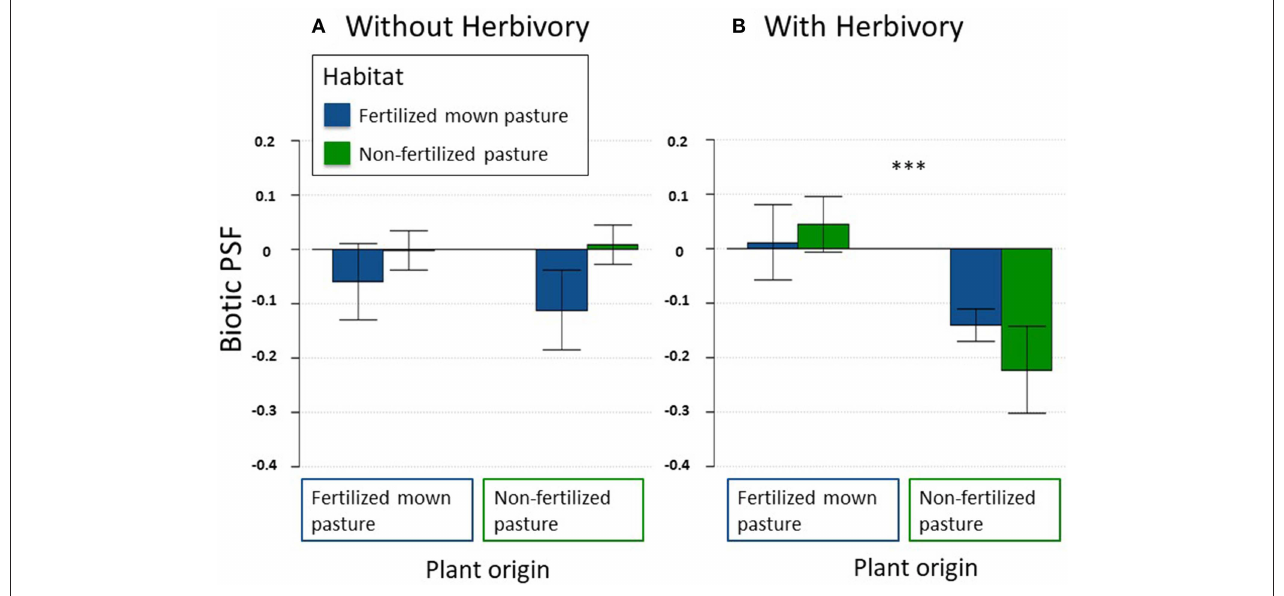
FIGURE 2 | Biotic plant-soil feedback [PSF; log(biomass on home soil/biomass on away soil)] of P. lanceolata grown without (A) and with (B) aboveground herbivorous insects. Within graphs, left bars represent plants that originated from fertilized mown pastures, whereas right bars represent plants from non-fertilized pastures. The habitat the plants grew in during the experiment is indicated by colors (blue: fertilized mown pastures, green: non-fertilized pastures). Data represent mean ± SE ( n = 30). Asteriks between bars represent signifigance, *** P <